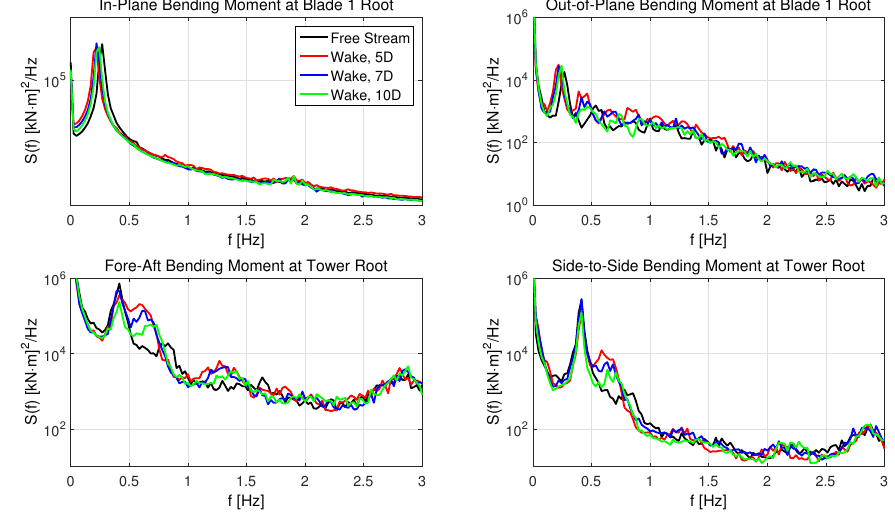
Figure 29. Power spectra of turbine loads in the free stream and wake based on LES.